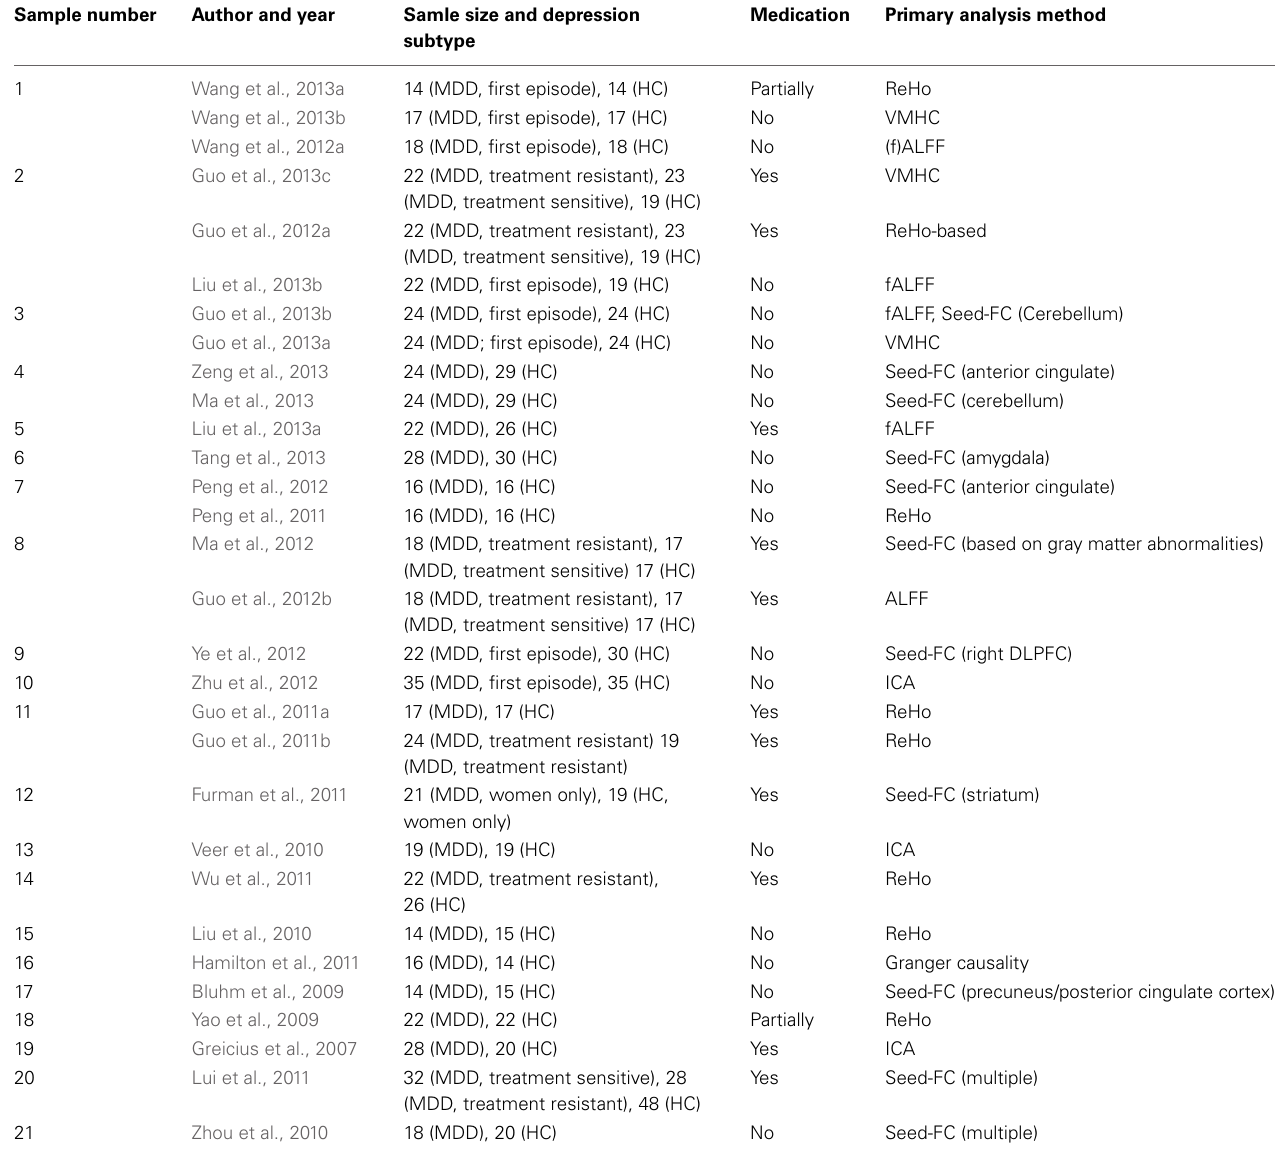
Table 1 | Studies in group A (representing mainly decreased connectivity/function in depression and ambiguous